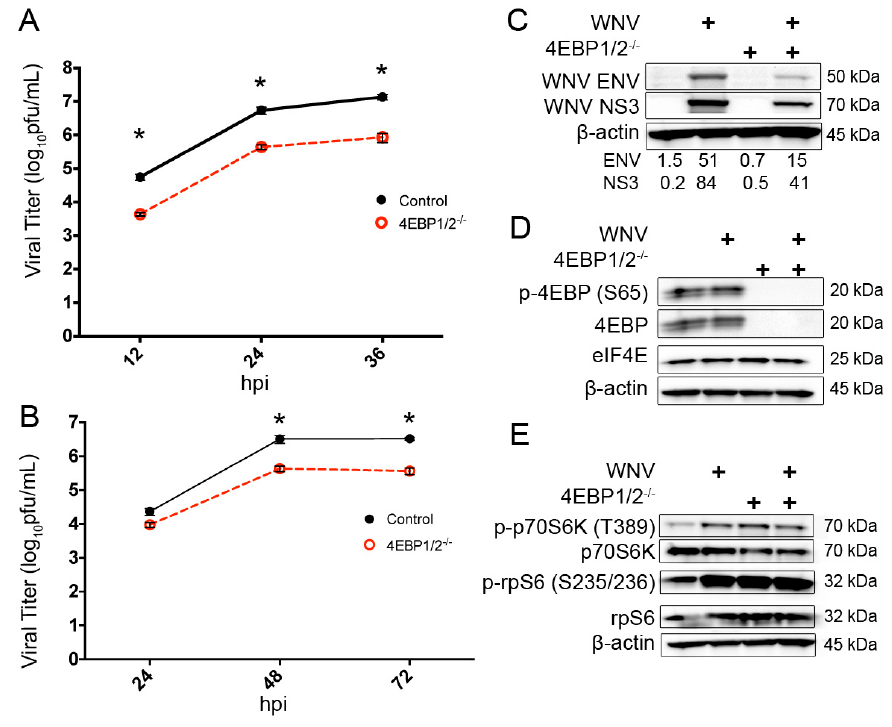
Figure 6. Expression of 4EBP1 and 4EBP2 support WNV growth and protein expression. ( A ) Single-step growth curve of WNV (MOI = 3) in 4EBP1/2 − / − and wild-type control MEFs; ( B ) Multi-step growth curve of WNV (MOI = 0.001) in 4EBP1/2 − / − and wild-type control MEFs. Supernatants